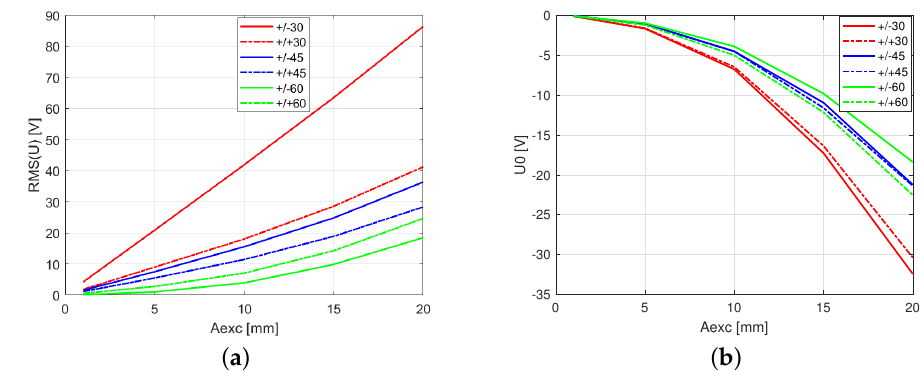
Figure 9. Root mean square of voltage response ( a , b ) the shift in the mean value of the voltage potential, calculated according to the formula U 0 = 0.5 ( U max + U min )